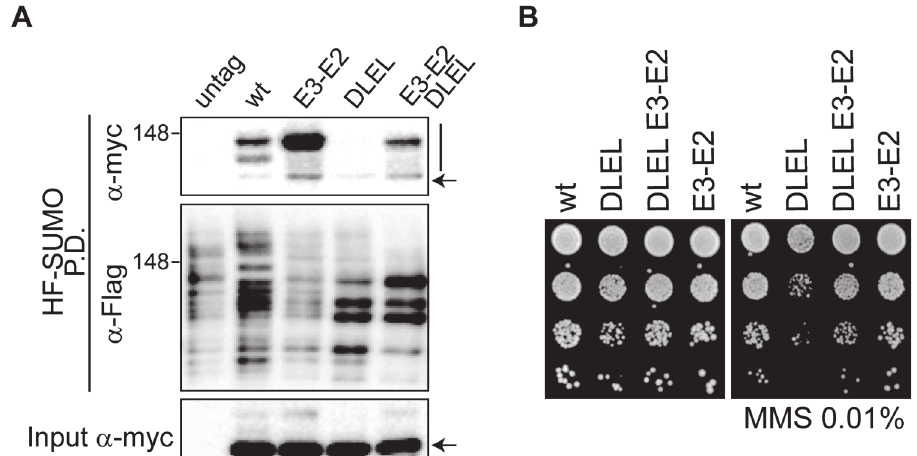
Fig 8. Up-regulation of Mms21-dependent sumoylation through expression of an E3-E2 fusion suppresses the smc5-DLEL coiled coil mutant. A . HF-SUMO pull-down analysis from wild-type or E3-E2 cells, expressing 9myc-tagged wild-type or DLEL mutant versions of the Smc5 protein form its endogenous location, as indicated. B . Growth test analysis of wild type, E3-E2 , smc5-DLEL , and double E3-E2 smc5- DLEL mutant cells; plates were incubated at 30°C in the presence or absence of 0.01% MMS. In A, arrow points to unmodified Smc5; vertical bars are sumoylated